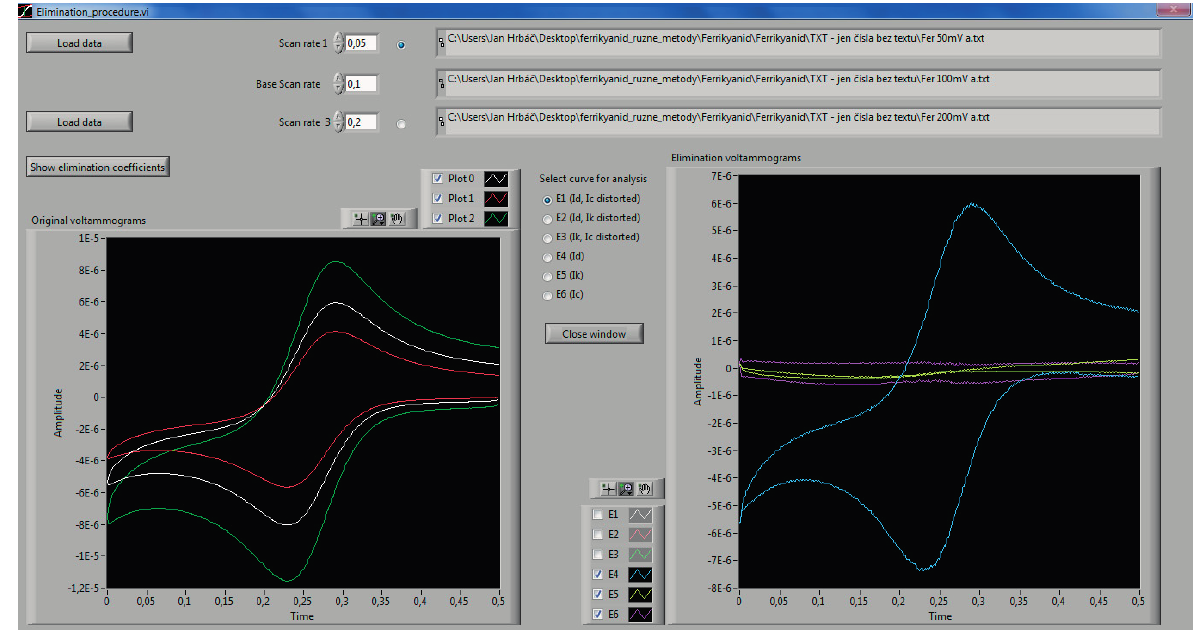
Figure 3. Elimination procedure dialog window, showing three ferricyanide voltammograms used for elimination (left graph) and voltammograms processed by elimination showing the diffusion, kinetic and capacitive partial currents (blue, yellow, resp. violet traces in the right